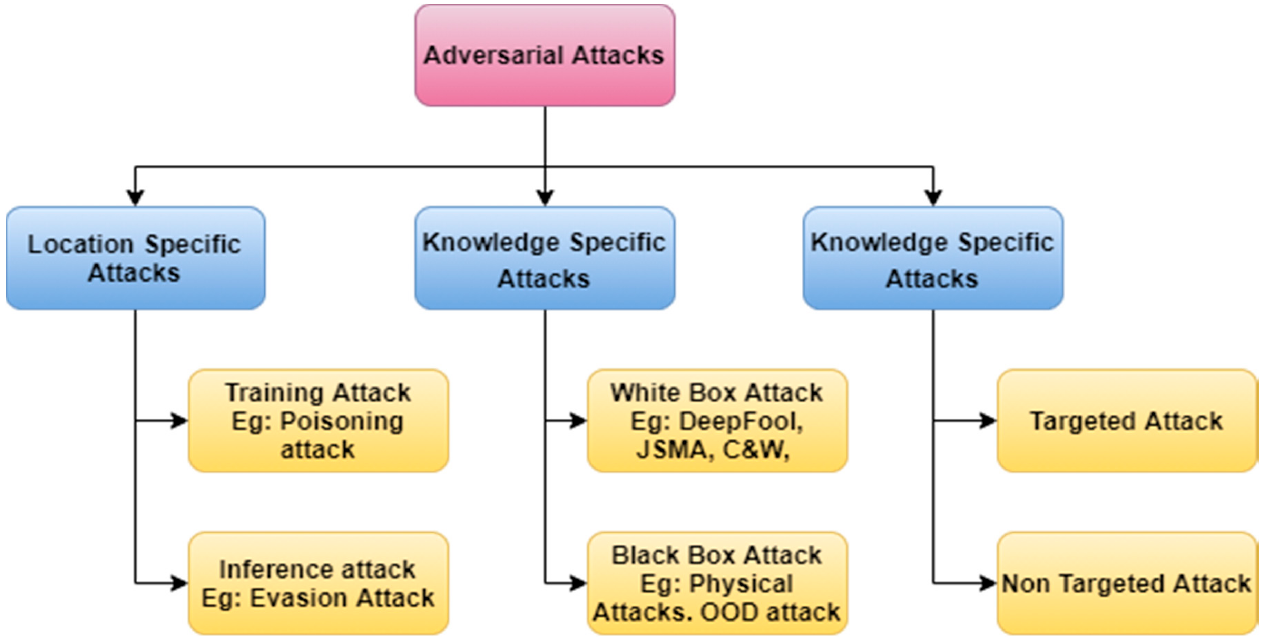
Figure 2. Different types of adversarial attacks and their classification.